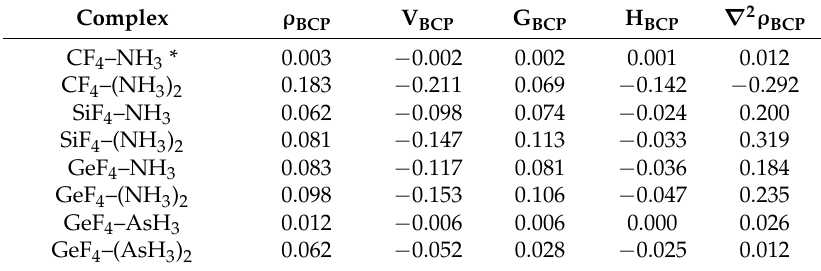
Table 2. The QTAIM characteristics (in au) of the Z–N(As) BCP (Z = C, Si, Ge); electron density